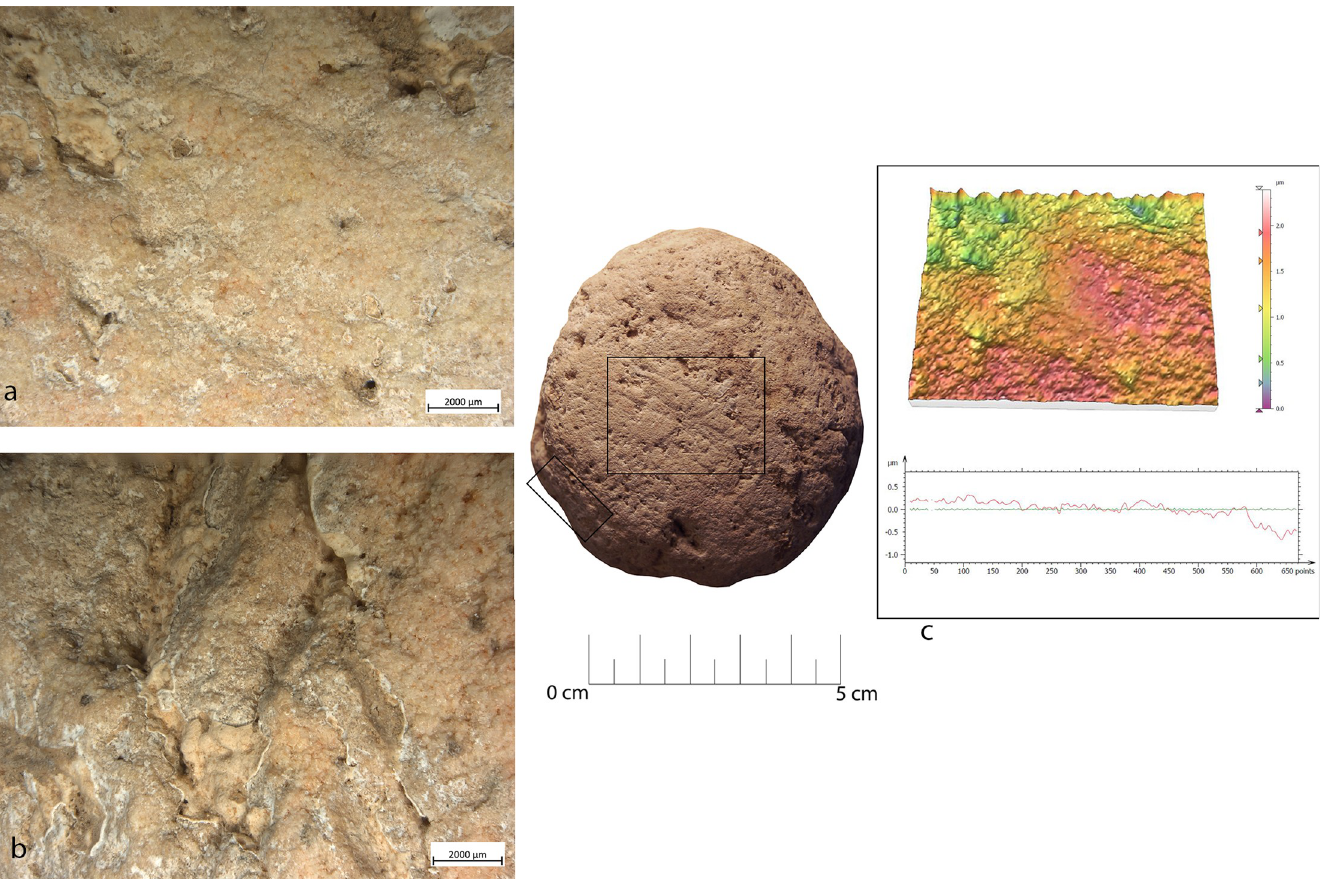
Fig 20. Use wear identified on artefact RF73. (a) Macro-traces (20x), long striations with different orientations located on the flat surfaces in the central area; (b) pits (20x) on the marginal surface, overlapping, covered by the patina. The artefact is affected by dissolution; (c) 3D microtopography of the used surface and